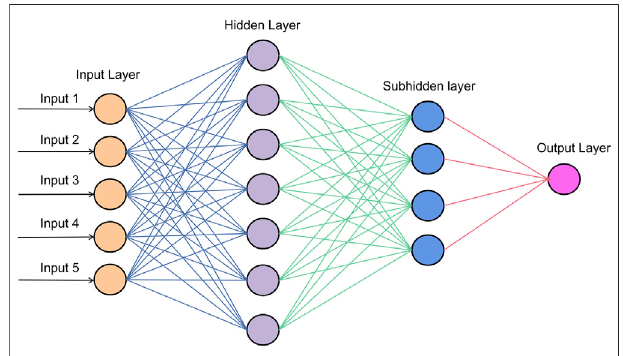
FIGURE 1 | Schematic representation of the topology of a BP neural